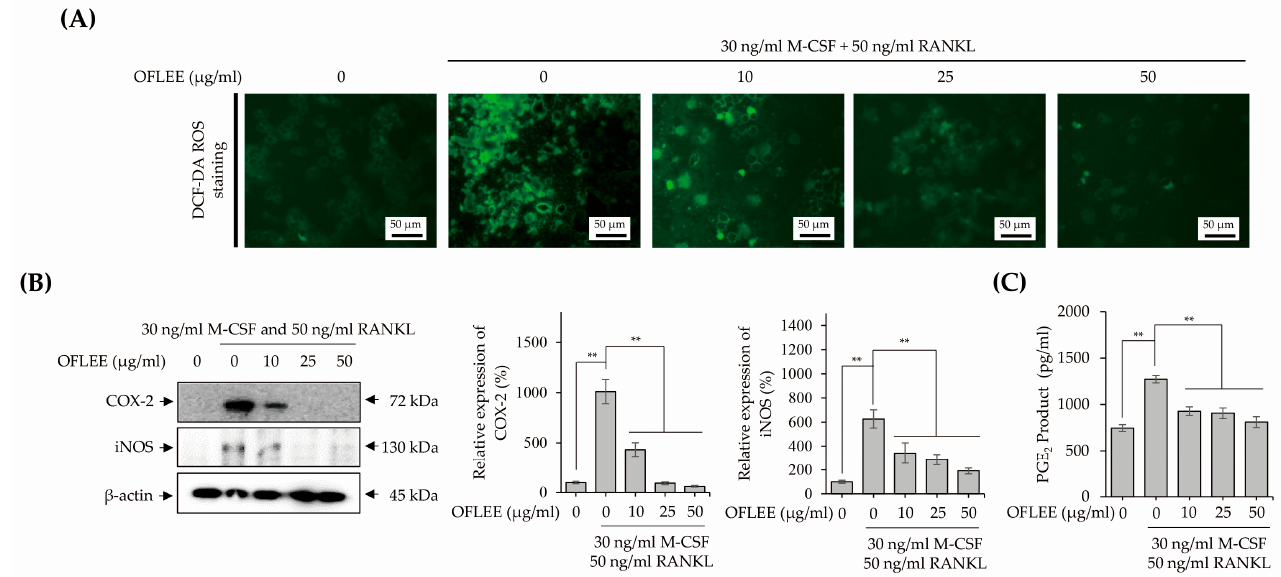
Figure 5. OFLEE suppresses the ROS production and the expression of inflammatory mediators such as iNOS, COX-2 and PGE 2 in the BMMs treated with M-CSF and RANKL. ( A ) OFLEE suppressed the M-CSF and RANKL-induced ROS production in BMMs. BMMs were treated with 0, 10, 25, and 50 μ g/mL OFLEE in the presence of 30 ng/mL M-CSF and 50 ng/mL RANKL for 72 h. Thereafter, ROS were detected using H2DCF-DA. Images were taken under an inverted fluorescence microscope. ( B ) The expression of inflammatory mediators such as iNOS and COX-2 was down-regulated by OFLEE in the BMMs treated with M-CSF and RANKL. ( C ) OFLEE decreased the production of PGE 2 in the BMMs treated with M-CSF and RANKL. BMMs were treated with 0, 10, 25, and 50 µ g/mL OFLEE in the presence of 30 ng/mL M-CSF and 50 ng/mL RANKL for 72 h. Thereafter, Western blot was performed to verify the expression of COX-2 and iNOS. β -actin was used as the internal control. In addition, PGE 2 production was measured using a PGE 2 Parameter Assay kit. Results are mean ± SD of three independent experiments ( n = 3), ** p <